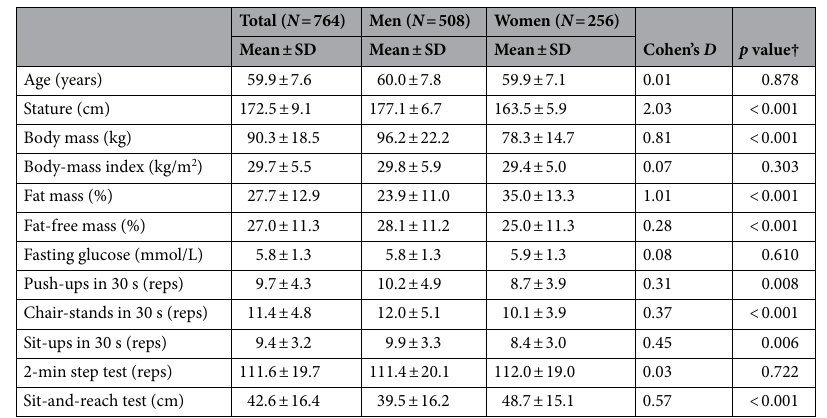
Table 1. Basic descriptive statistics of the study participants ( N = 764). † Denotes using the analysis of covariance (ANCOVA) for normally distributed or Man–Whitney Z -test for not normally distributed variables; p < 0.05.